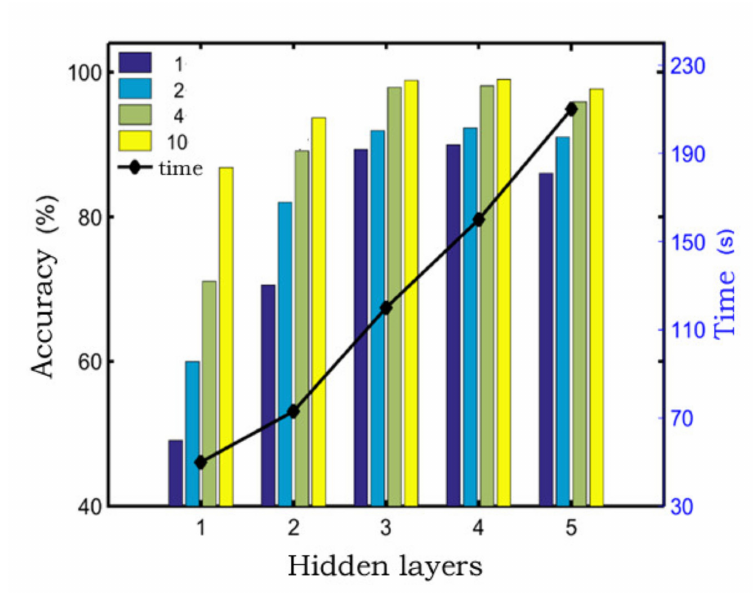
Figure 6. The accuracy under different hidden